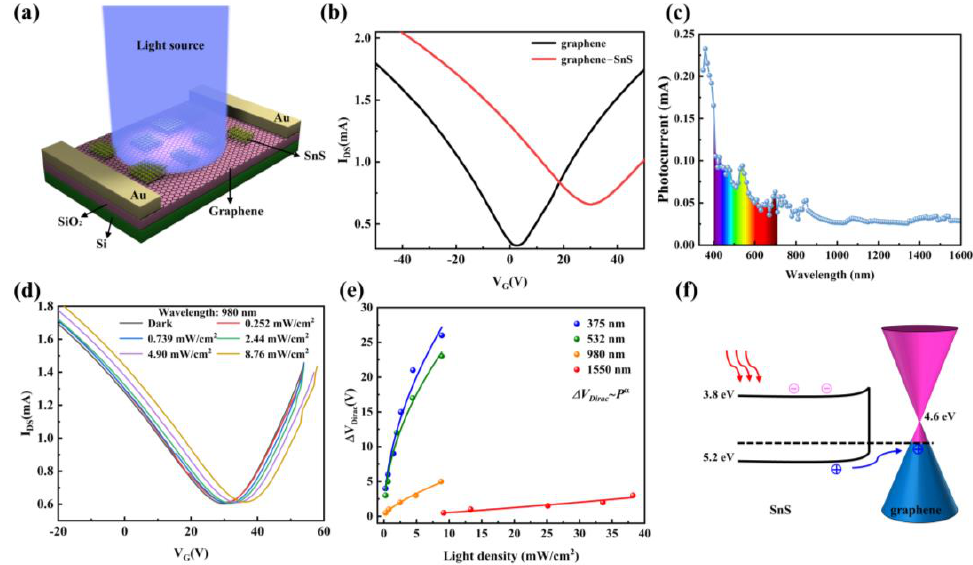
Figure 2. ( a ) Device characterizations of SnS nanoflakes/graphene heterostructure phototransistor. ( b ) The transfer characterization of the transistors based on pure graphene and SnS nanoflakes/graphene heterostructure in the dark, V DS = 0.1 V. ( c ) Spectral response curve of the phototransistor based on SnS nanoflakes/graphene heterostructure, V G = 0 V, V DS = 1 V. ( d ) The transfer characteristics curve of the hybrid phototransistor at 980 nm light with different power density, V DS = 0.1 V. ( e ) The summary plot of the shift of the Dirac point as a function of light power density with different wavelengths. The lines were obtained by fitting a power function. ( f ) Schematic of the photoresponse mechanism of SnS nanoflakes/graphene heterostructure.